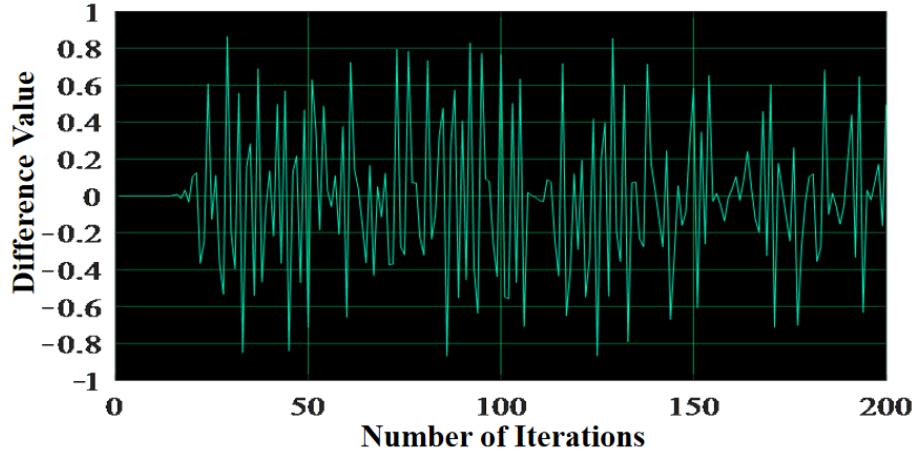
Figure 3. The output of logistic map.